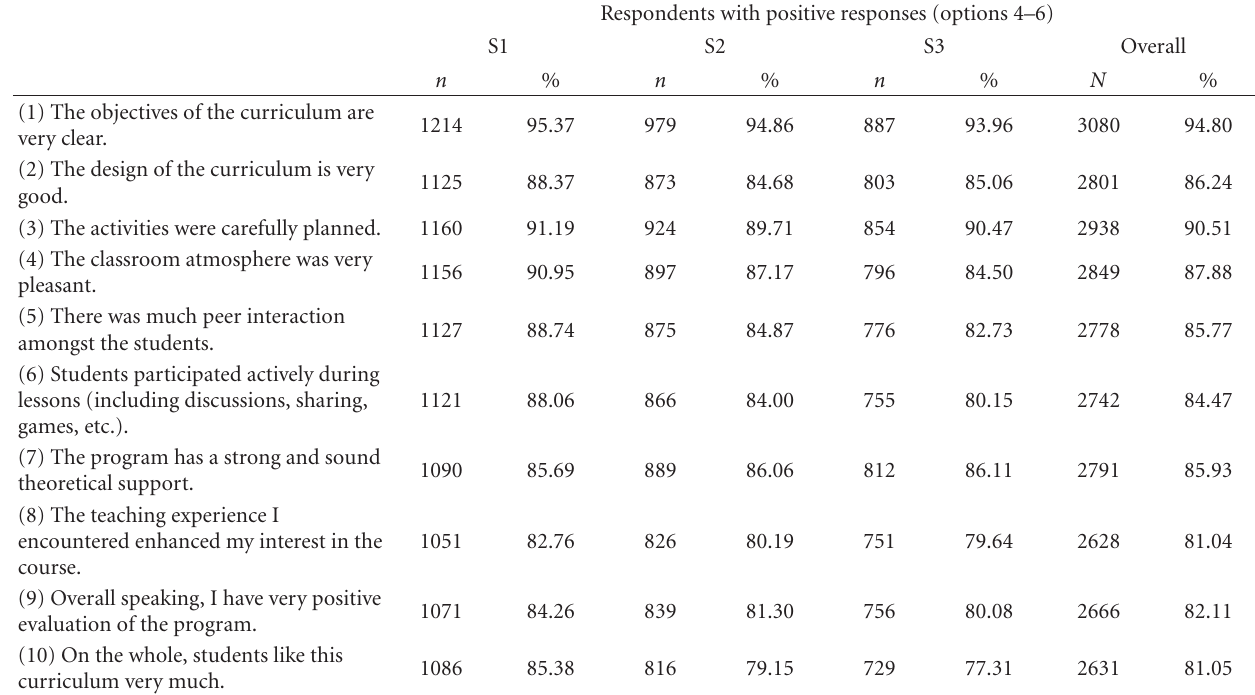
Table 1: Summary of the program implementers’ perception towards the program.